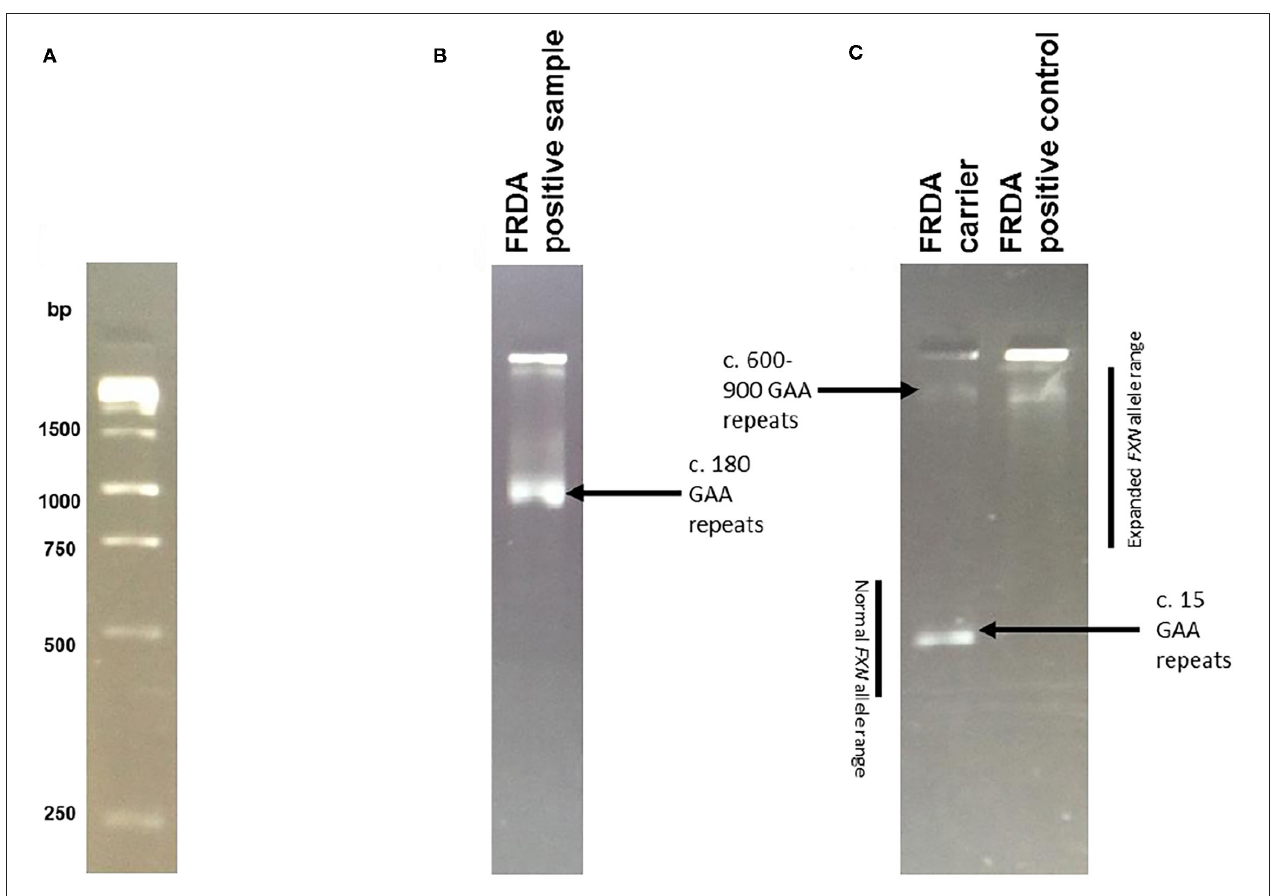
FIGURE 1 | Long PCR Results. Example of results obtained by Long Range PCR, visualised on a 2% agarose gel following electrophoresis. To calculate the number of GAA repeats, the required formula was allele size = (number of base pairs-450)/3. The reasoning behind this calculation is that the synthesised PCR products contain flanking sequences totaling 450 base pairs in addition to the GAA trinucleotide repeat expansion. Normal alleles run at approximately 500 base pairs, whereas affected alleles run at approximately 720 base pairs of above. (A) The 1kb ladder used to calculate expansion sizes. (B) An example of an FRDA positive sample, with c. 180 GAA repeats. (C) An example of an FRDA carrier and positive control. The FRDA carrier control has one large GAA expansion of between 600 and 900 repeats and one GAA expansion of only 15 repeats, within the normal range. The FRDA positive control has two large GAA expansions of between 600 and 900